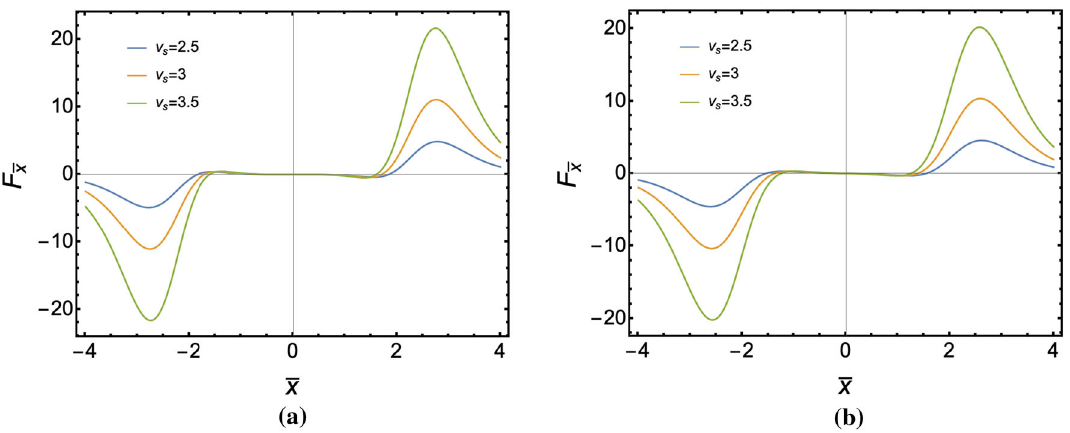
Fig. 3 The ¯ x component of the Tidal force with a ρ = 0, b ρ = 1 as a function of ¯ x for different v s . Warp bubble parameters are R = 2, σ = 1 in natural unit